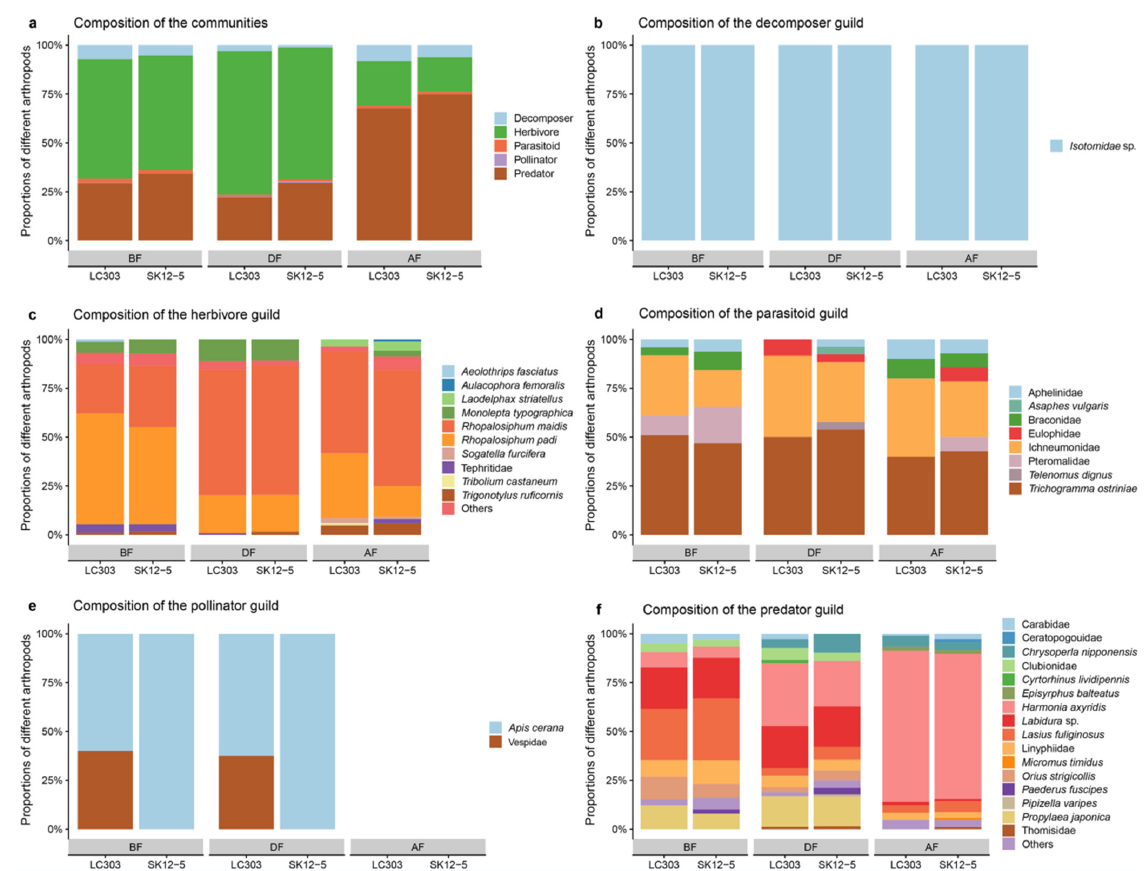
Figure 3. Composition of non-target arthropod (NTA) communities in SK12-5 ( Bt ) and LC303 (non- Bt ) maize fields for three main maize growth stages: BF—Before Flowering, DF—During Flowering and AF—After Flowering. ( a ) NTA communities; ( b ) decomposers; ( c ) herbivores; ( d ) parasitoids; ( e ) pollinators; and ( f ) predators.